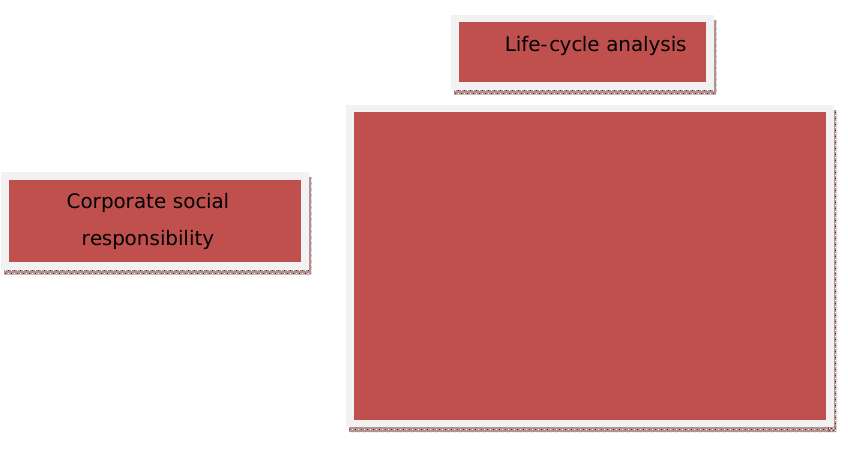
Figure 1. “Life-cycle analysis and corporate social responsibility”. Source: